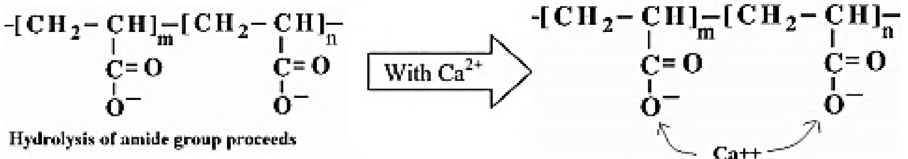
Fig. 1 Trapping the acrylamide molecule by divalent ion (Jiang and Zhu 2014)